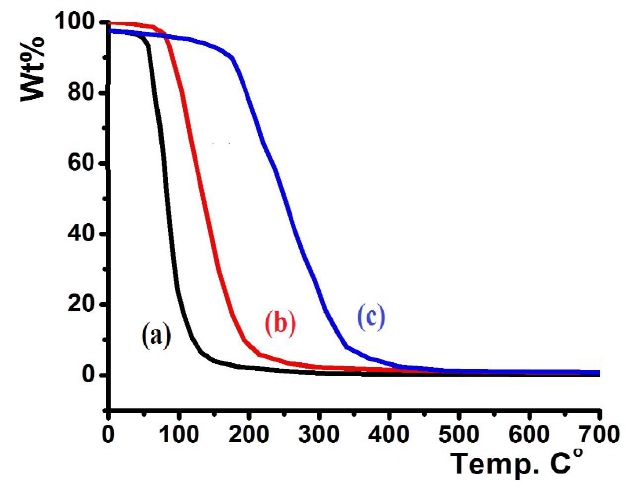
Figure 7. TG/DTG thermal curves of: (a) L2 , (b) L3 , and (c) L1. Figure 7. TG / DTG thermal curves of: (a) L2 , (b) L3 , and (c)